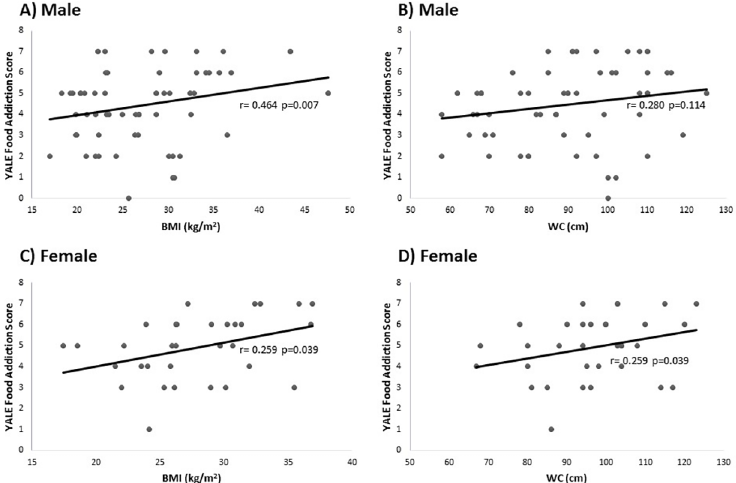
Fig 1. The correlations between YALE food addiction score and body mass index (BMI) or waist circumference (WC) of the participants with food addiction based on the gender. Scatter plot of food addiction scores and (A) BMI (kg/m 2 ) (r = 0.464, p = 0.007) and (B) WC (cm) (r = 0.280, p = 0.114) among male participants with food addiction (n = 33). Scatter plot of food addiction scores and (C) BMI (kg/m2) (r = 0.259, p = 0.039) and (D) WC (cm) (r = 0.259, p = 0.039) among female participants with food addiction (n =